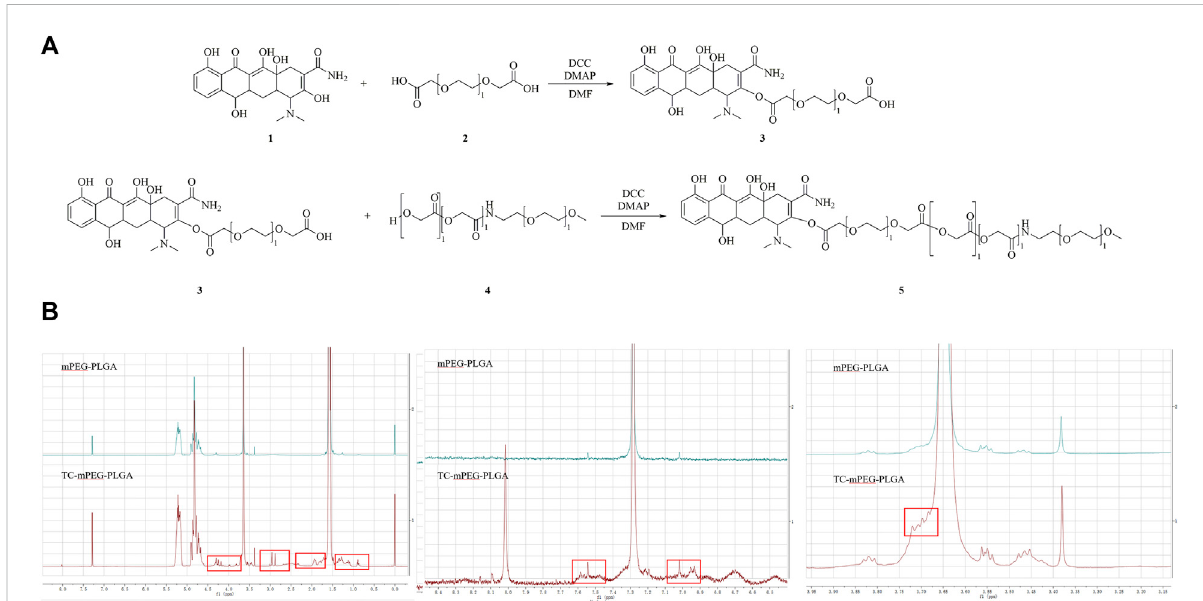
FIGURE 1 ThechemicalofTC-mPEG-PLGAandsynthesisrouteofTCgraftedmPEG ‒ PLGAmicelles (A) and 1 H-NMRspectraofTCandTCgraftedmPEG ‒ PLGA micelles (B) . TC, tetracycline; DCC, N, N ′ -dicyclohexyl-carbodiimide; DMAP, 4-dimethyl-aminopyridine; DMF, N, N-dimethylformamide; mPEG ‒ PLGA, methoxy poly-(ethylene-glycol) ‒ poly-(D, L-lactic-co-glycolic